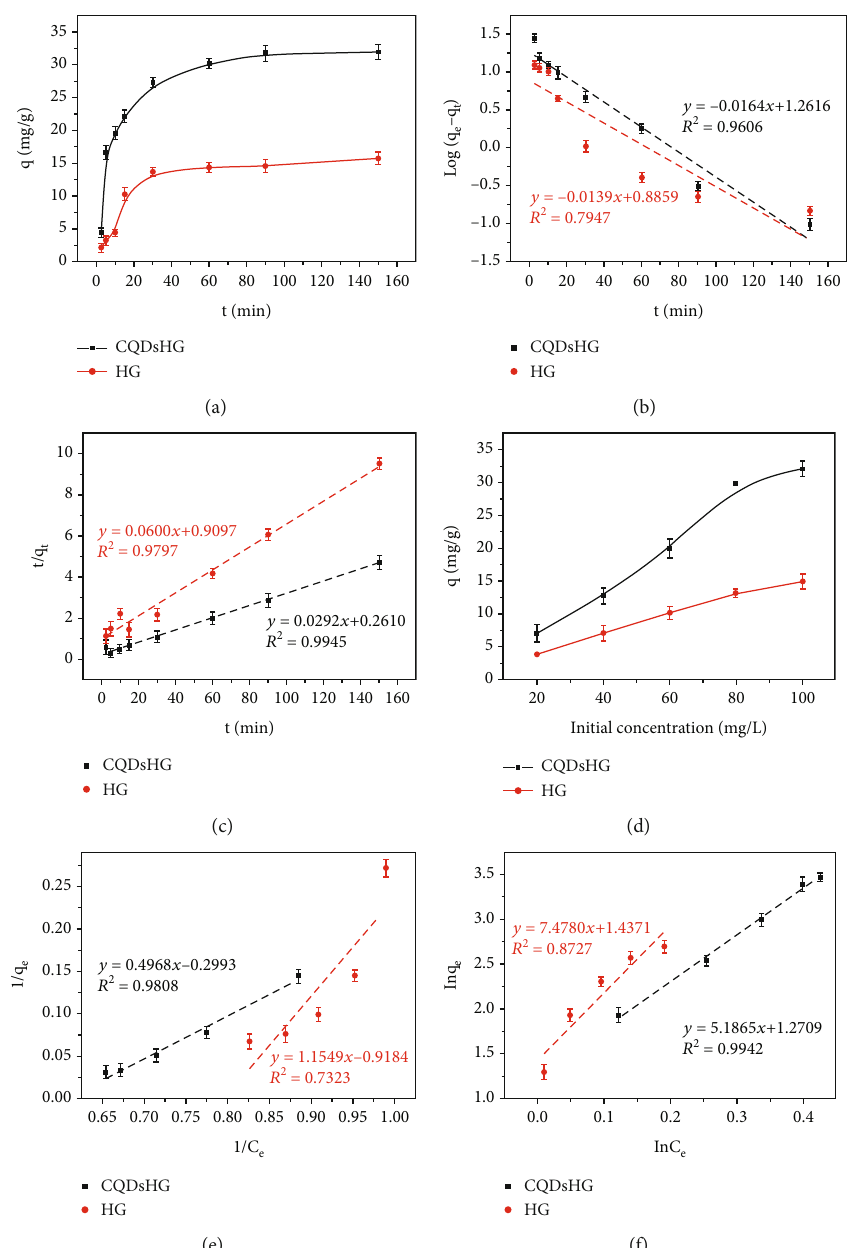
Figure 5: (a) The equilibrium adsorption amount of the CQDsHG and HG for Fe 3+ , (b) quasi- fi rst-order and (c) quasi-second order kinetics plots for the adsorption of the Fe 3+ on CQDsHG and HG, (d) e ff ect of initial concentrate of Fe 3+ on adsorption, (e) linear plots of Langmuir, and (f) Freundlich isotherms for Fe 3+ adsorption by the CQDsHG and HG. Table 1: Kinetic parameters of quasi- fi rst-order and quasi-second-order models for Fe 3+ adsorption on hydrogels. Quasi- fi rst-order , exp Adsorbents q e